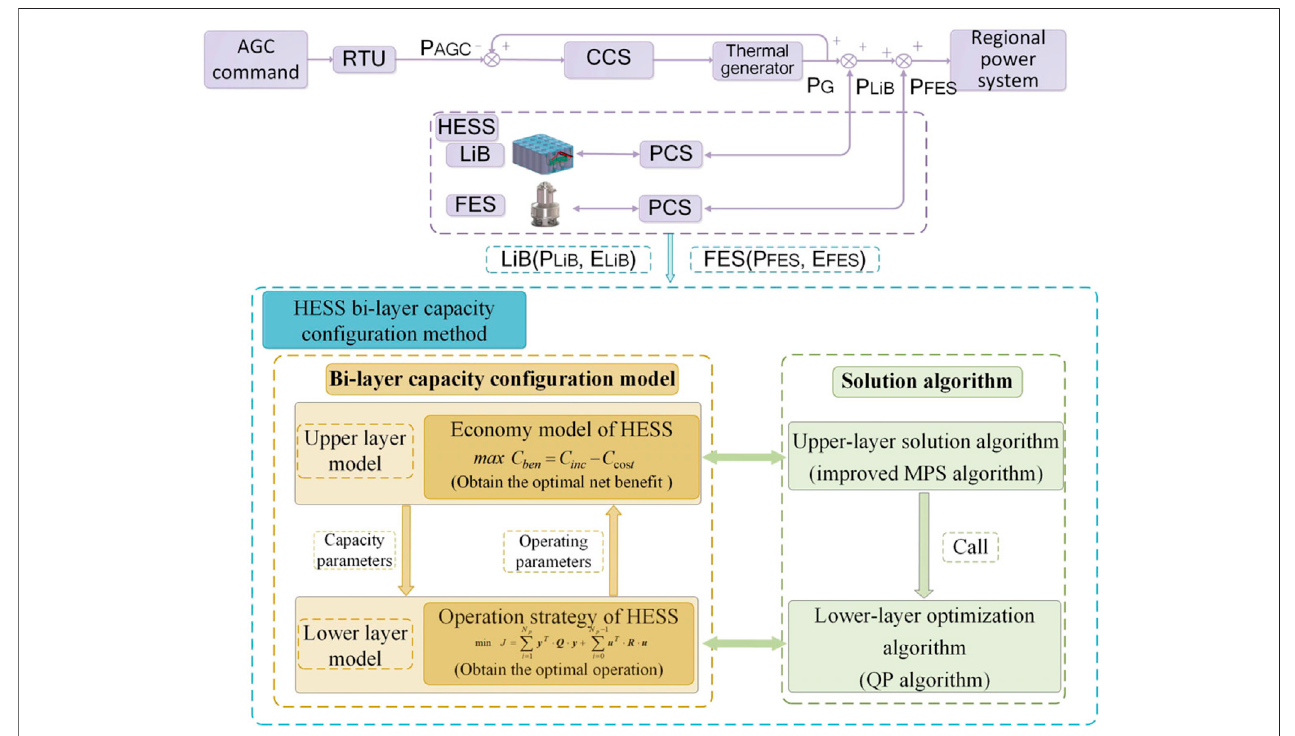
FIGURE 1 | Overview of the proposed bi-layer capacity con fi guration